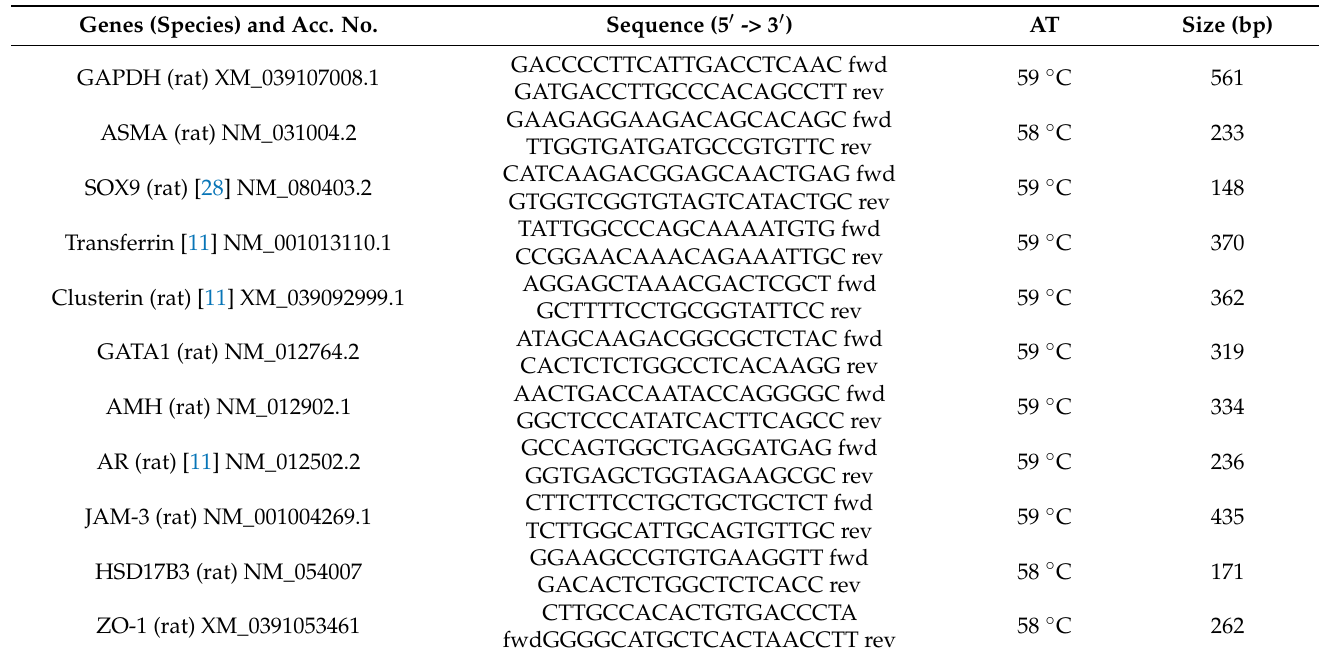
Table 1. List of primer sequences used for RT-PCR or